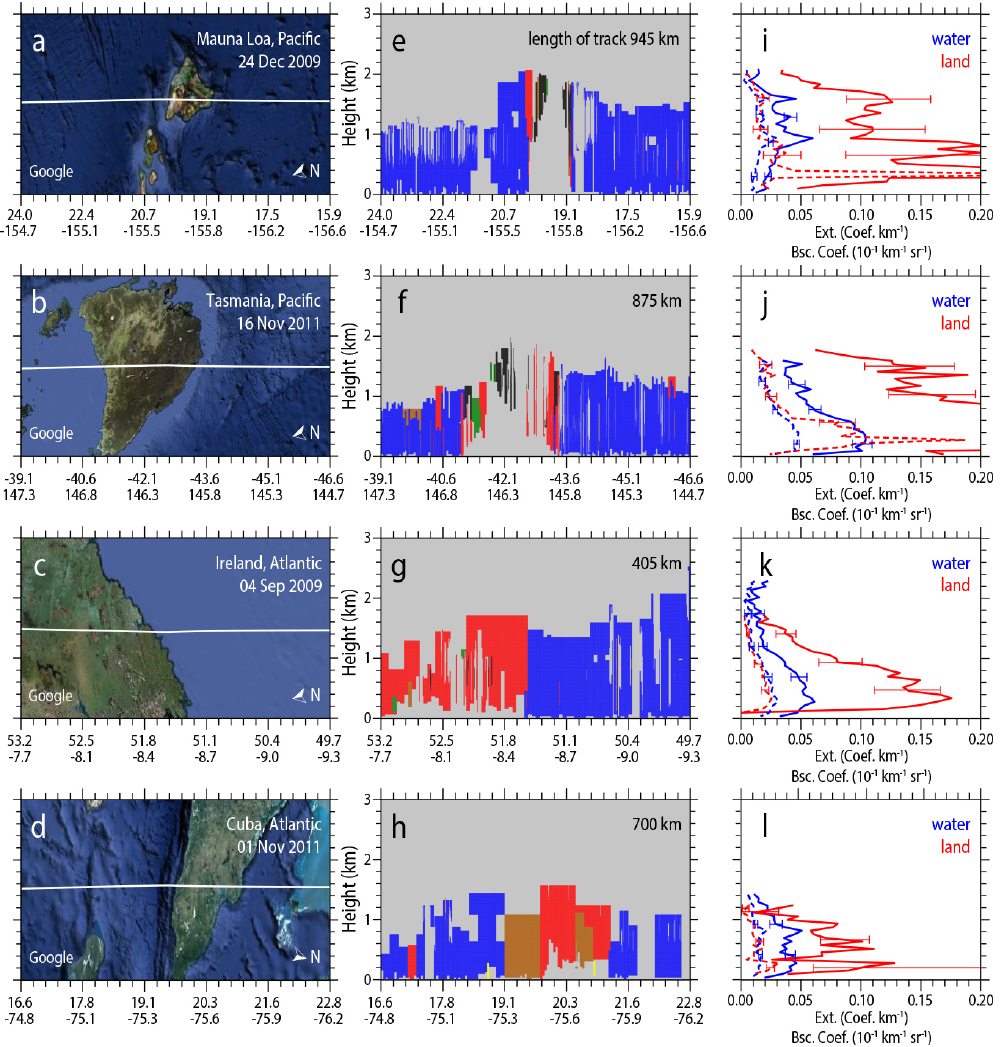
Figure 8. (a–d) Surface type information from Google Earth map of different coastal areas. Flight tracks of selected CALIPSO overflights are indicated by the white lines. Axis numbers show the coordinates of the flight track (upper row: latitude, lower row: longitude). (e–h) Height– time display of the aerosol subtype mask as determined with CALIPSO during overflight of the location to the left. The length of the selected cross section is given at the right top. (i–l) Corresponding mean profiles of 532nm backscatter (dashed) and extinction coefficient (solid) separately for water (blue) and land surface